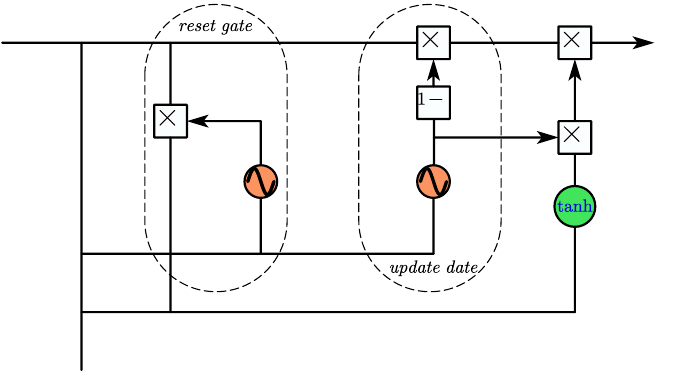
Figure 4. GRU model structure.